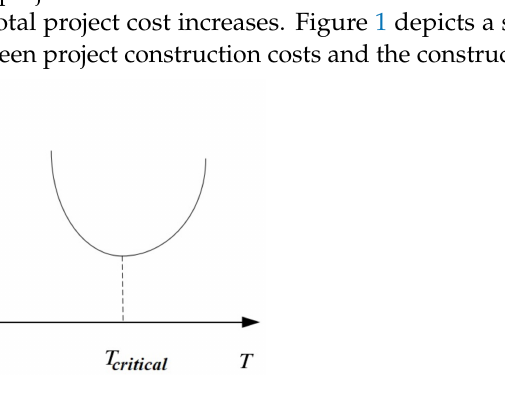
Figure 1. Diagram depicting the relationship between construction cost and construction